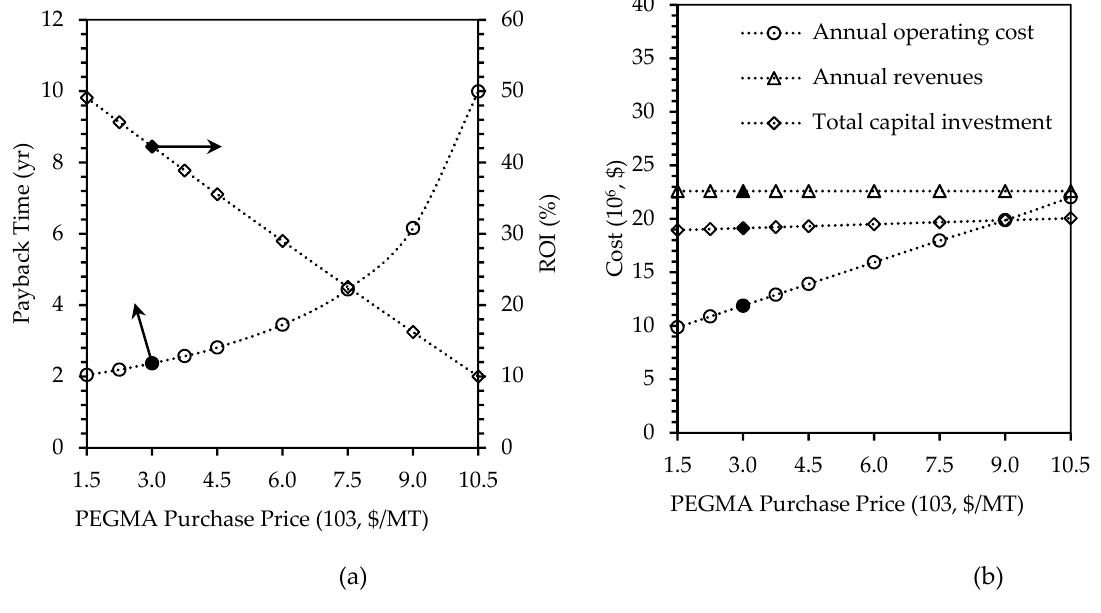
Figure 9. Effects of changing PEGMA purchase price, on ( a ) payback time in years and ROI in percent, and ( b ) annual operating cost, annual revenues, and total capital investment in U.S. dollars. Filled markers represent results of the base case scenario.